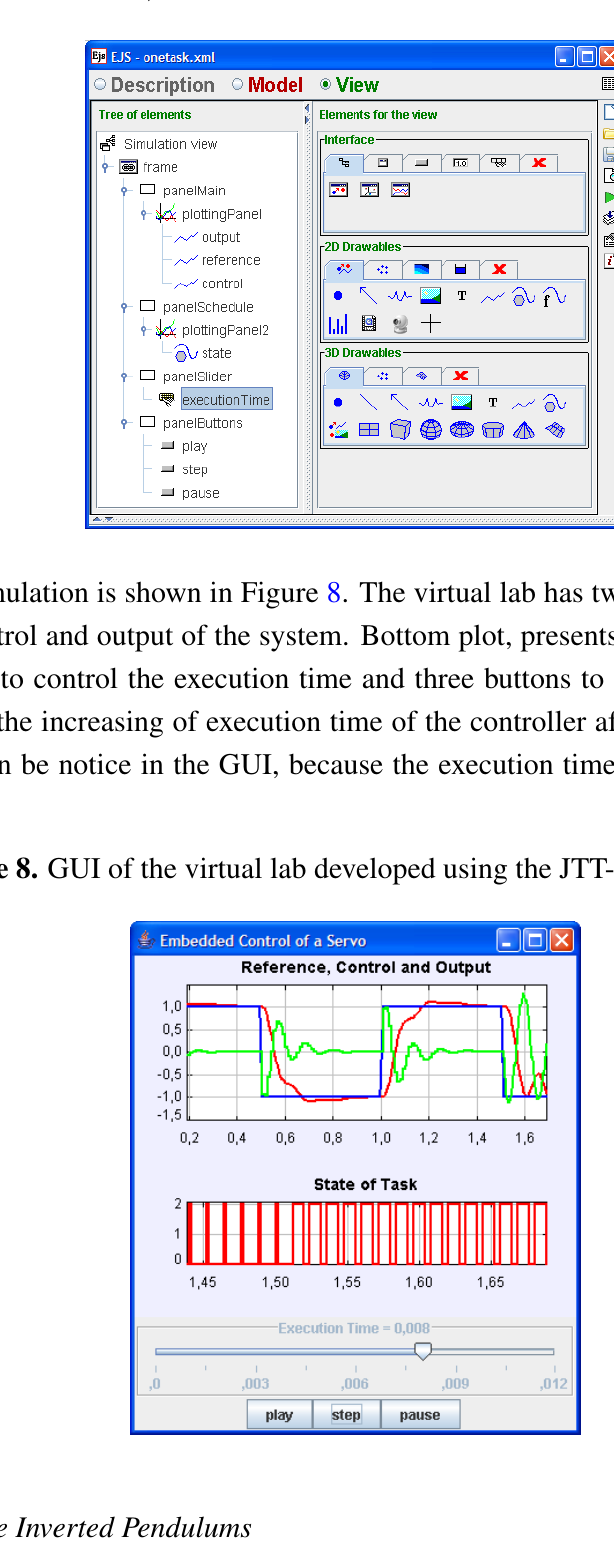
Figure 7. Section View of the EJS. Elements on the right are provided by EJS to build the tree-like structure on the left, which describes the GUI of the simulation of Figure 8.